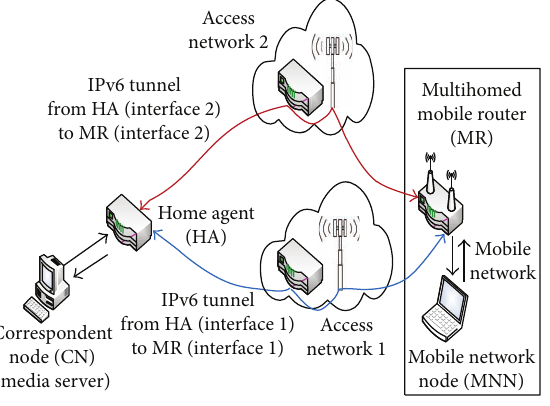
Figure 1: Topology of a two-path multihomed mobile network. Figure 2: Extracting an H.264/SVC scalable bit